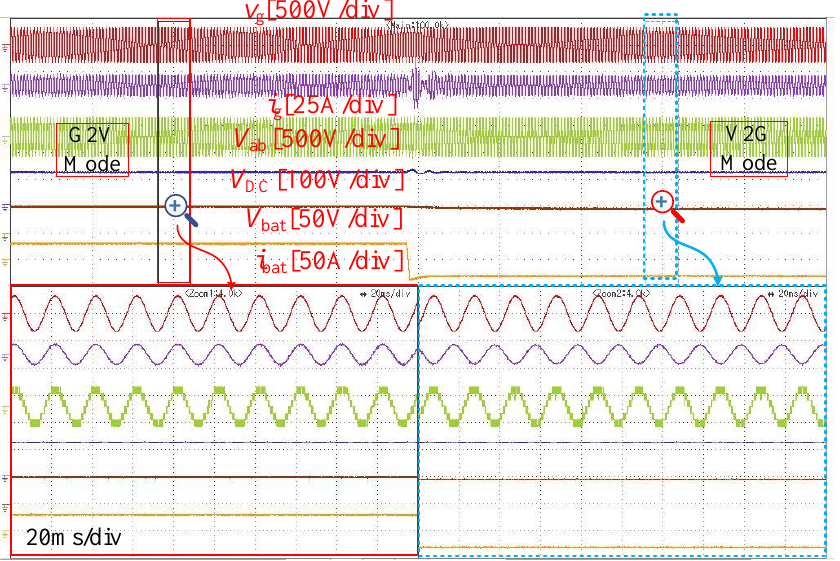
Figure 20. Single-phase EV charging (G2V) and power injected back to the grid (V2G) with unity power factor.